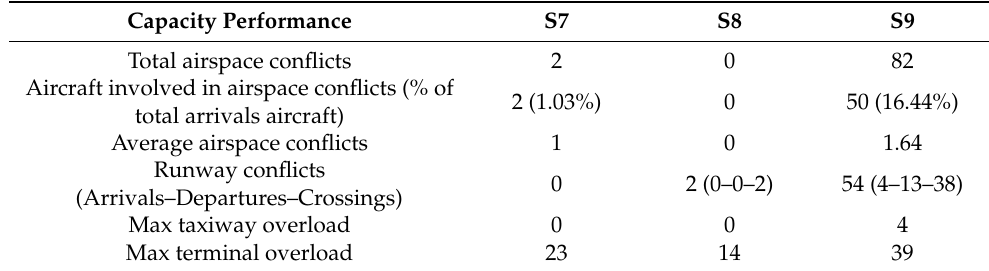
Table 11. Capacity performance for scenarios S7, S8 and S9.